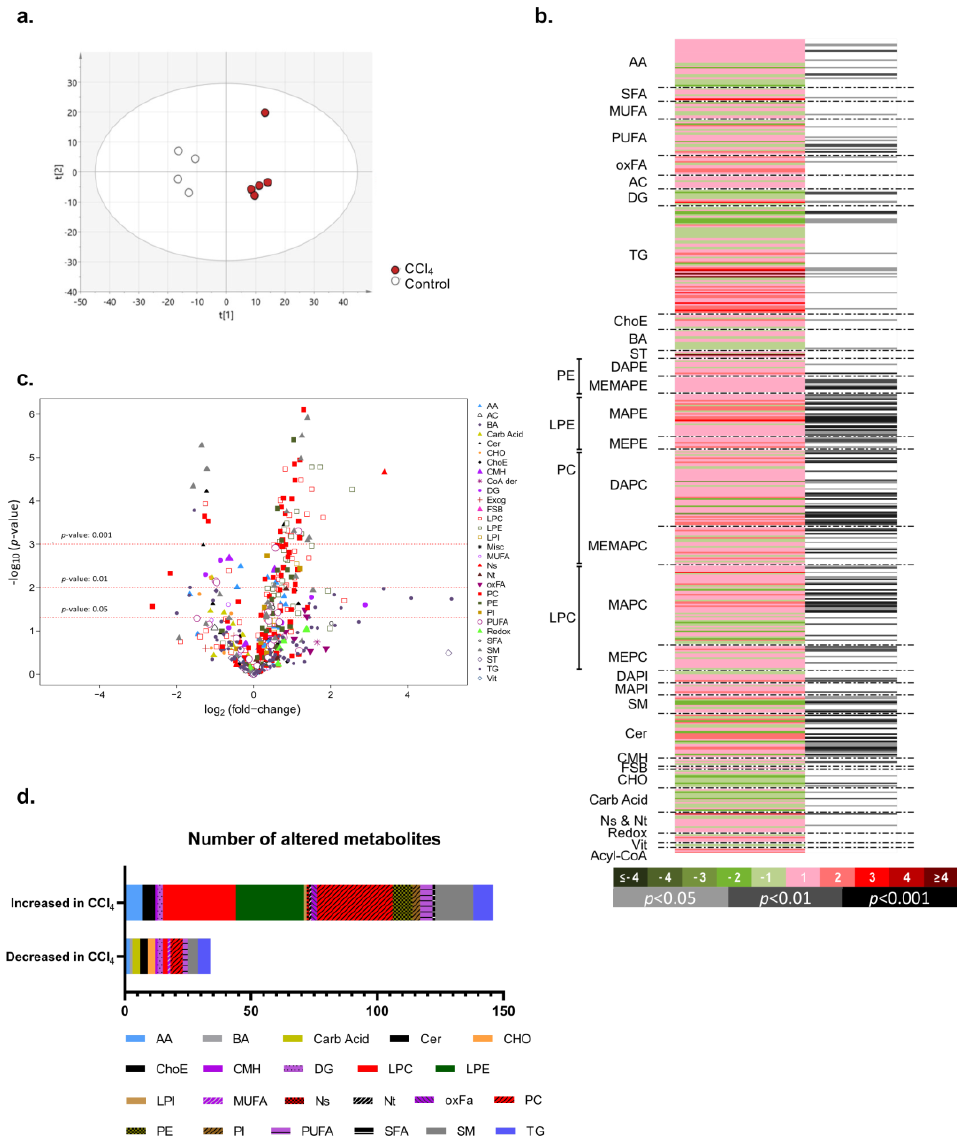
Figure 2. Untargeted metabolomics analysis reveals metabolic hepatic reprogramming in carbon tetrachloride (CCl 4 )-induced liver fibrosis. Three-month-old C57BL/6 wild-type animals ( n = 4) were compared to animals treated with carbon tetrachloride (CCl 4 ) once a week for 6 weeks (0.6 mL/kg) ( n = 5). ( a ) Principal component analysis (PCA) where the data matrix is reduced to a series of principal